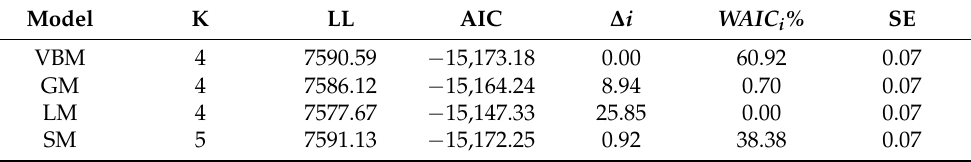
Table 7. Growth model selection for models fitted to raw age–length data bolstered by simulated values of the temperate Sardinops sagax stock in the southern California Current System (CCS). K is the number of parameters; LL is the maximum log likelihood; AIC is Akaike’s information criterion; ∆ i is Akaike’s differences; WAIC i % is Akaike’s weight for each model; SE is the standard